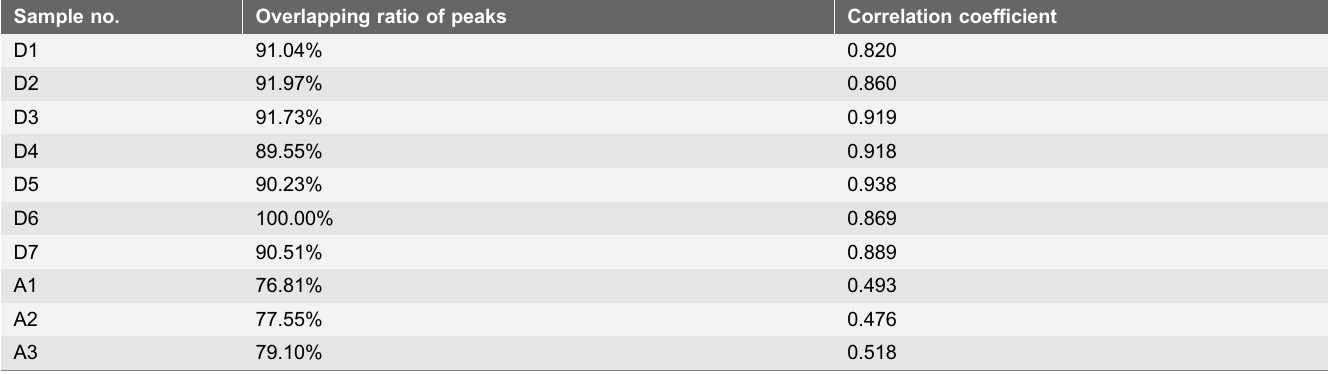
Table 2. The overlapping ratio of peaks and correlation coefficien similarity of 10 tea samples. Sample